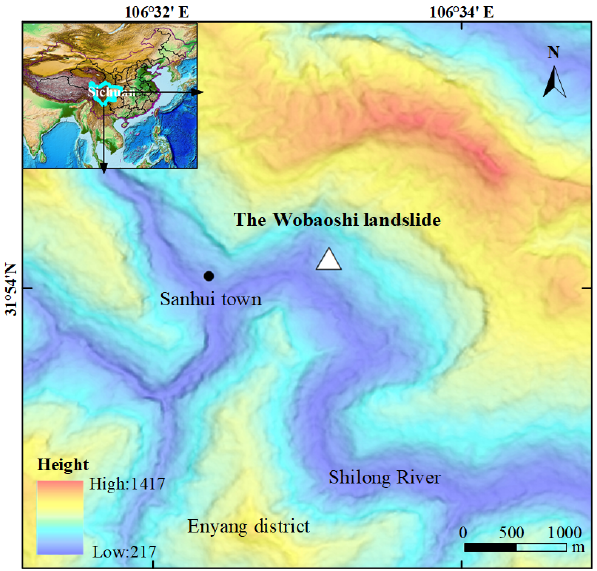
Figure 1. Geographic location and elevation map of the Wobaoshi